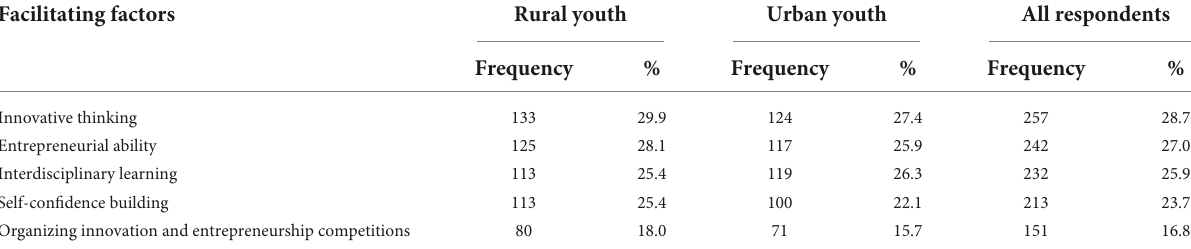
TABLE 12 Cultivation of innovation and entrepreneurial